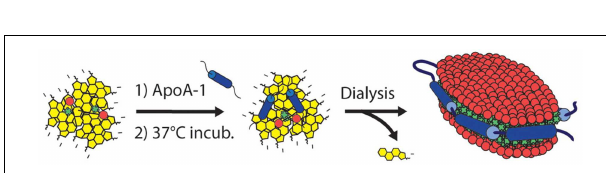
FIGURE 9 | Schematic of the self-assembling process resulting in porphysome nanodics (Adapted with permission from Ng et al. [117]).